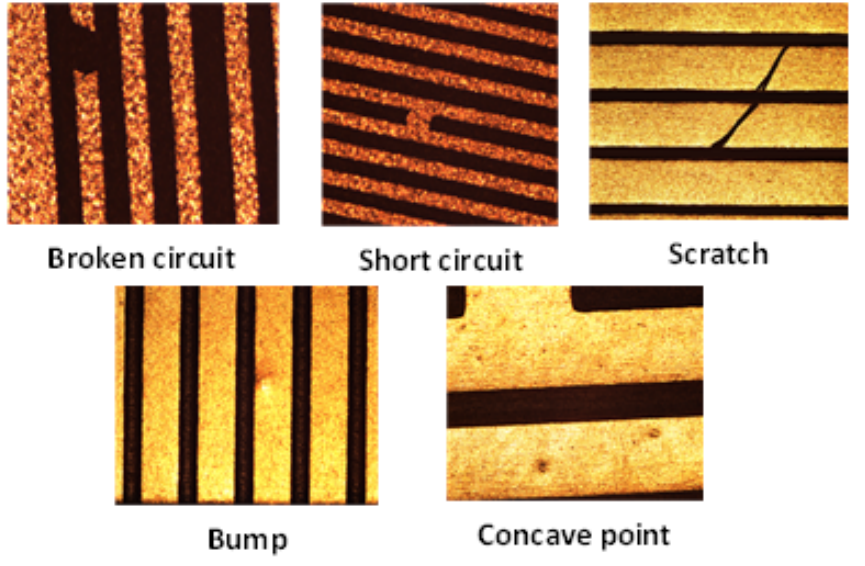
Figure 4. FICS line